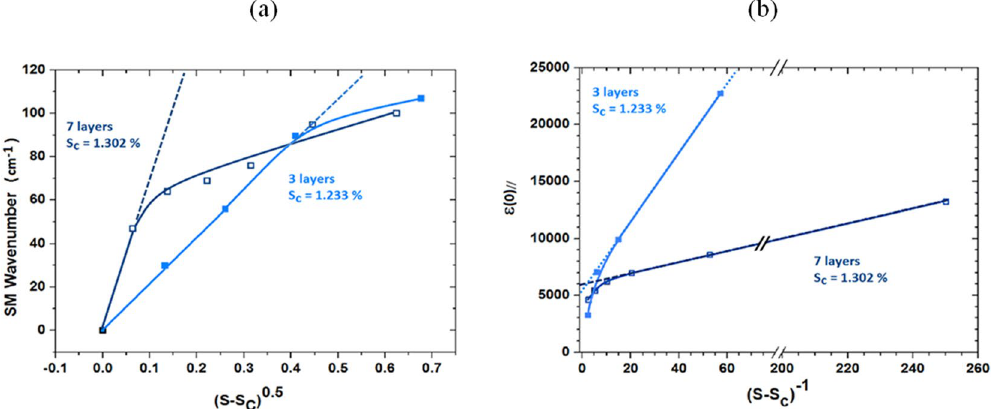
Figure 4. Representation of the ferroelectric Curie law as a function of strain for STO slabs of 3 and 7 layers. ( a) Soft mode frequency dependence on the square root of strain. ( b) Static parallel dielectric constant dependence on the inverse of strain. The dashed lines are the representations of the Curie law. One observes that the Curie law is followed in a much larger strain range for slab of 3 layers which can be explained by the much larger role of surfaces in this